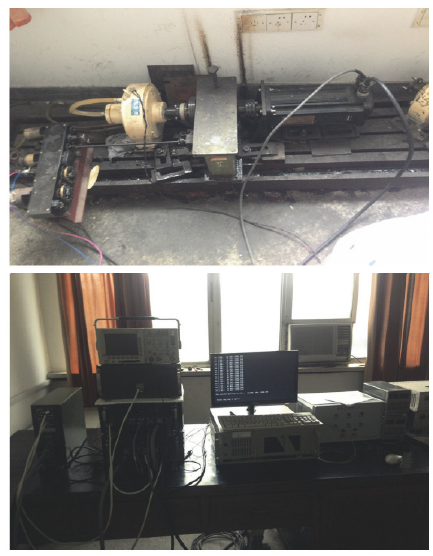
Figure 12: Photograph of the semiphysical simulation platform.